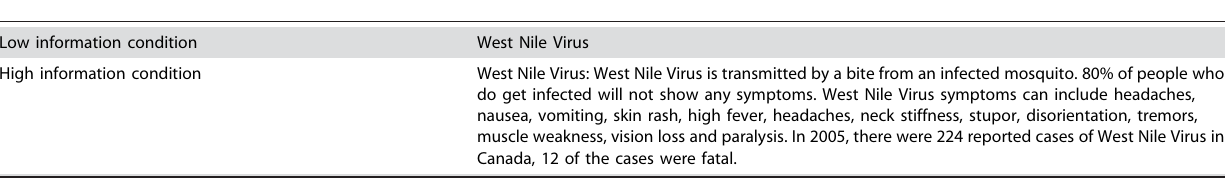
Table 1. Informational Conditions: